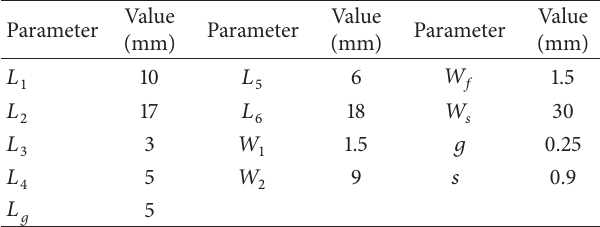
Table 1: Geometrical parameters of the proposed antenna.